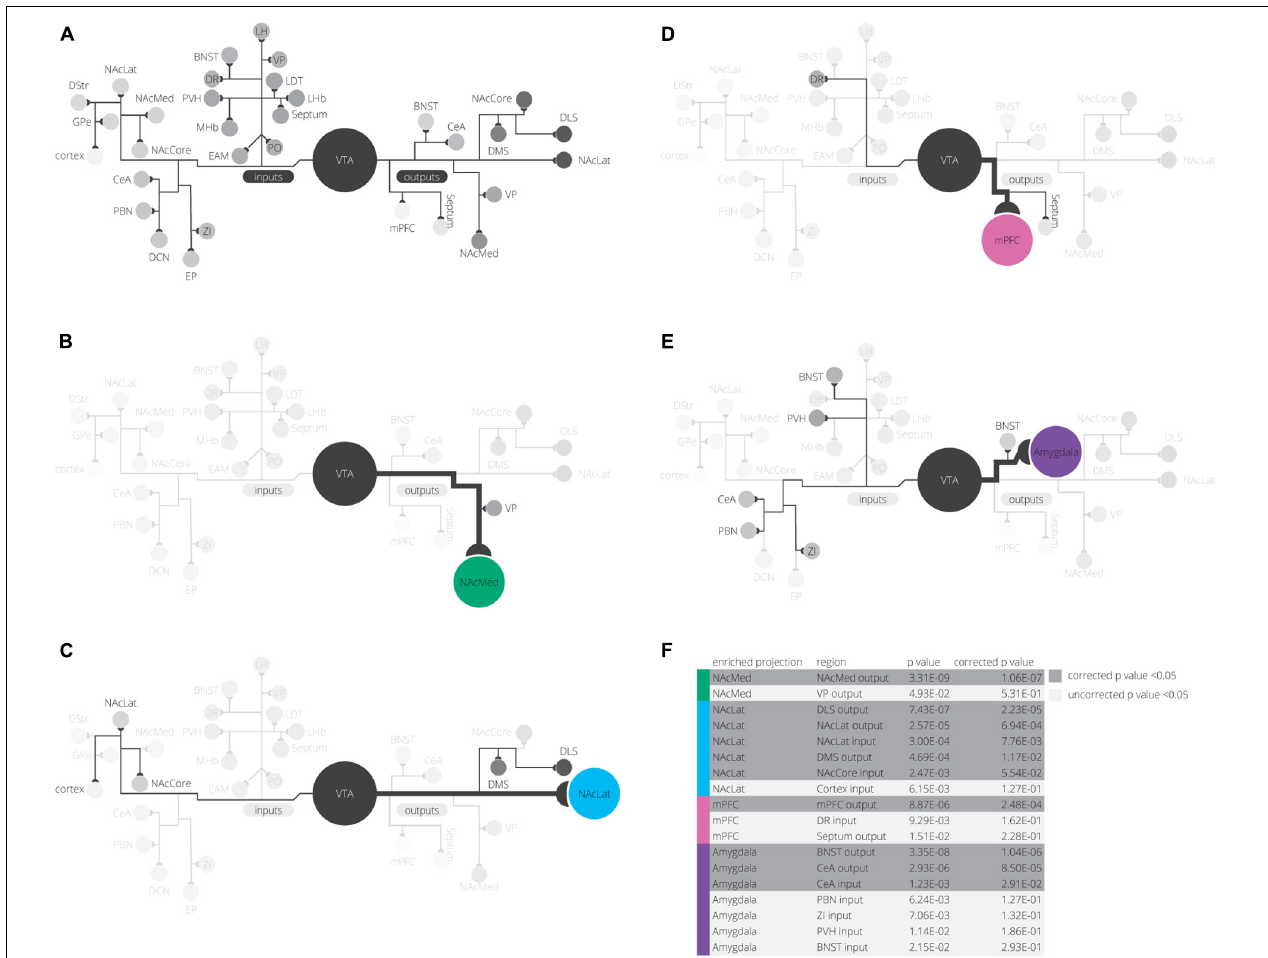
FIGURE 6 | Summary of findings. (A) All inputs and outputs we mapped in our experiments are shown, grouped in their clusters from UMAP analysis. (B–E) For each projection, elevated inputs and outputs are shown (according to Figure 3G ). (F) Inputs or outputs significantly elevated in any projection condition are shown grouped by projection. p -values are corrected for multiple comparisons using a Bonferroni